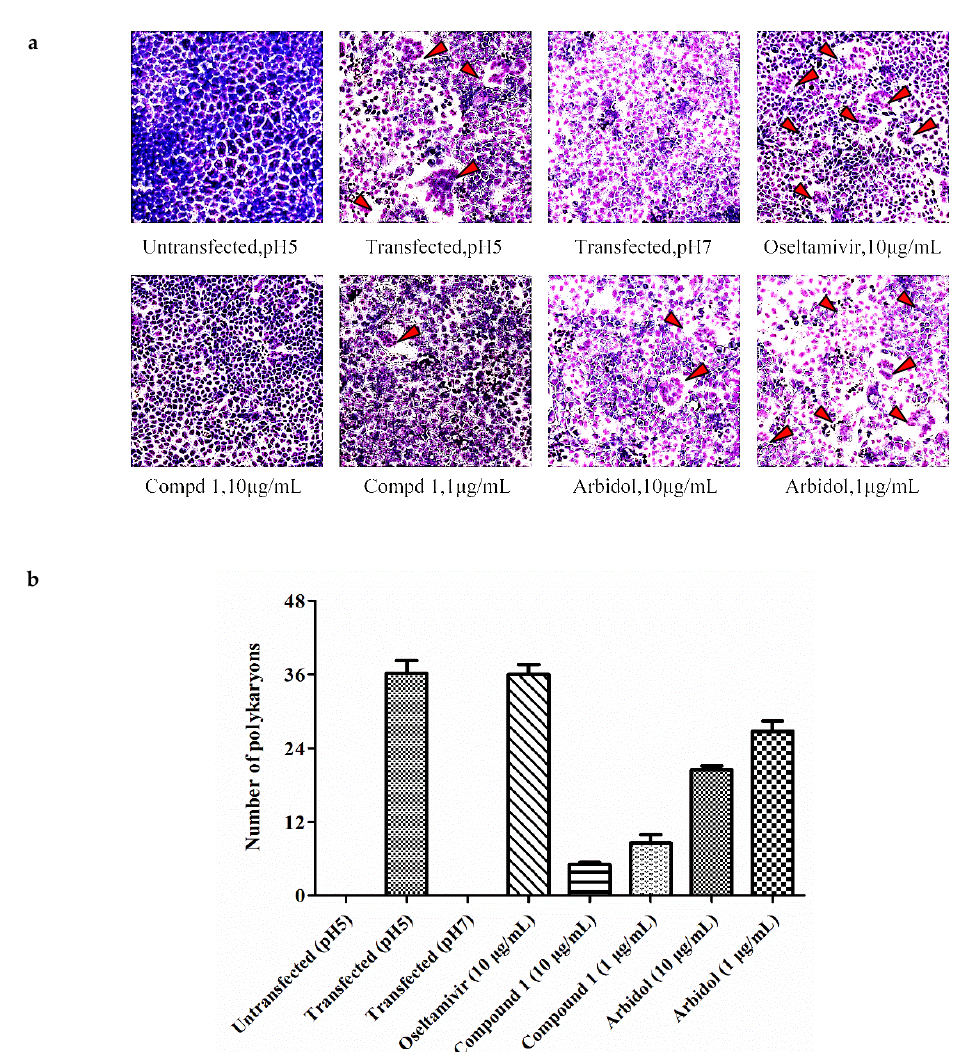
Figure 5. ( a ) Polykaryon formation inhibition assay (100 × ). ( b ) Syncytium formation was quantified by counting the number of polykaryons.